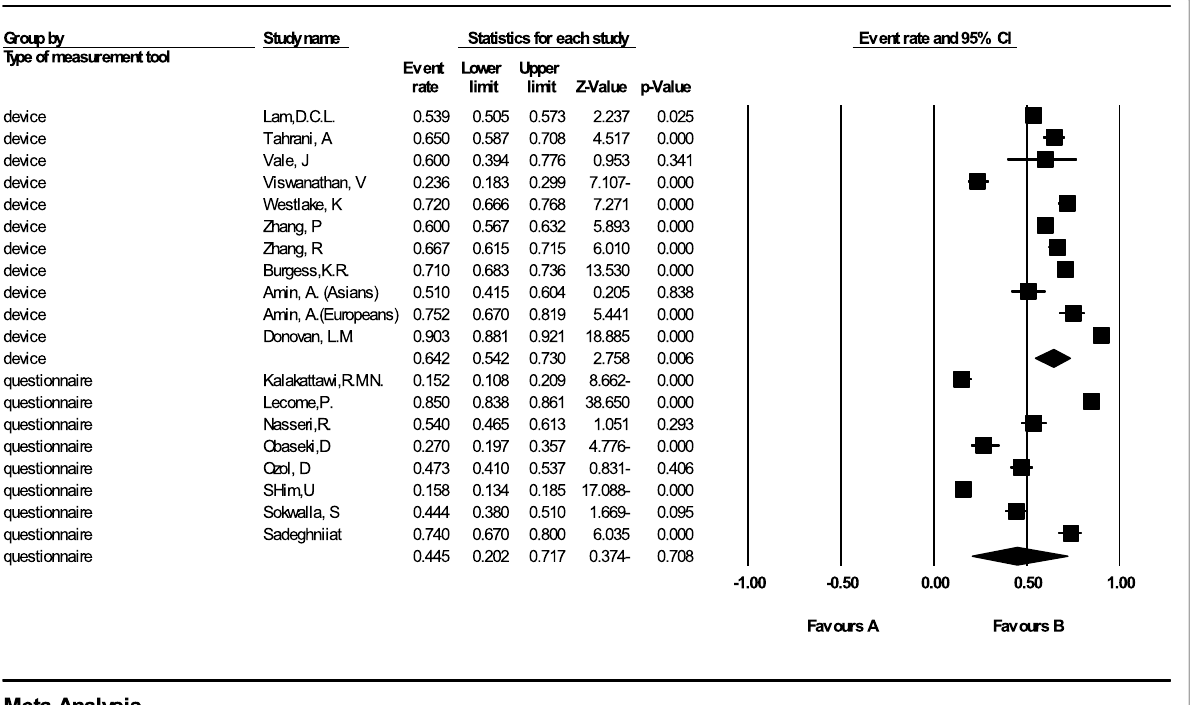
Fig. 5 Forest plot for the prevalence of OSA based on type of diagnostic